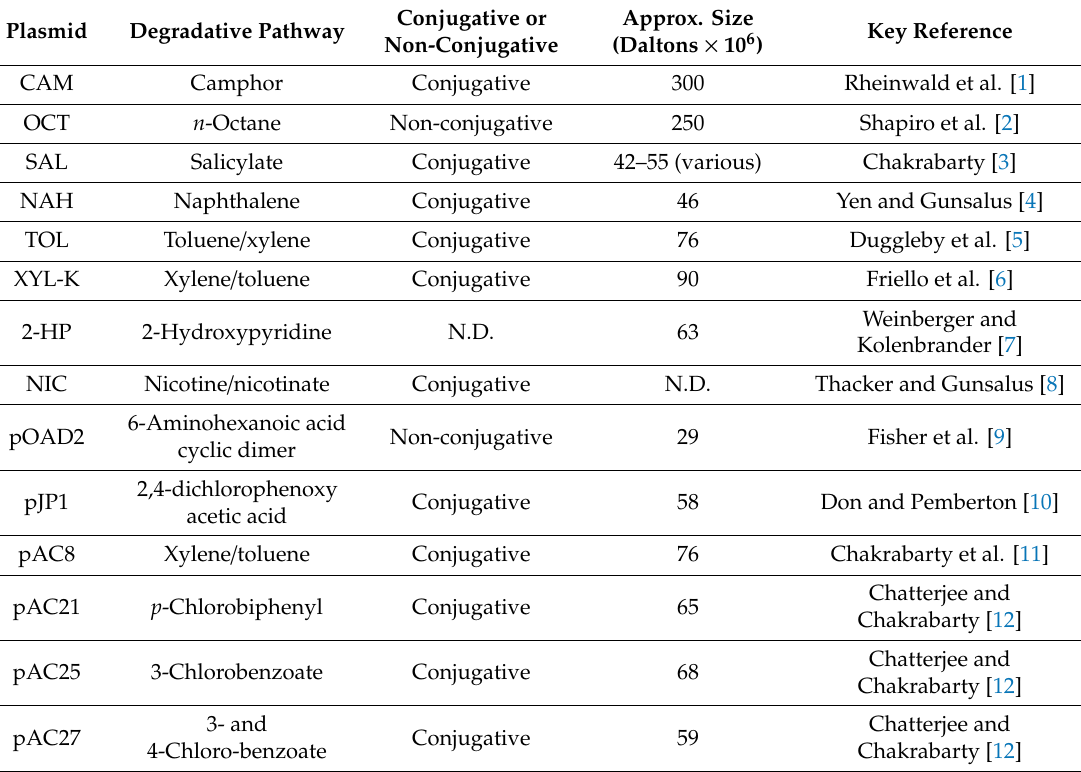
Table 1. Naturally occurring degradative plasmids in